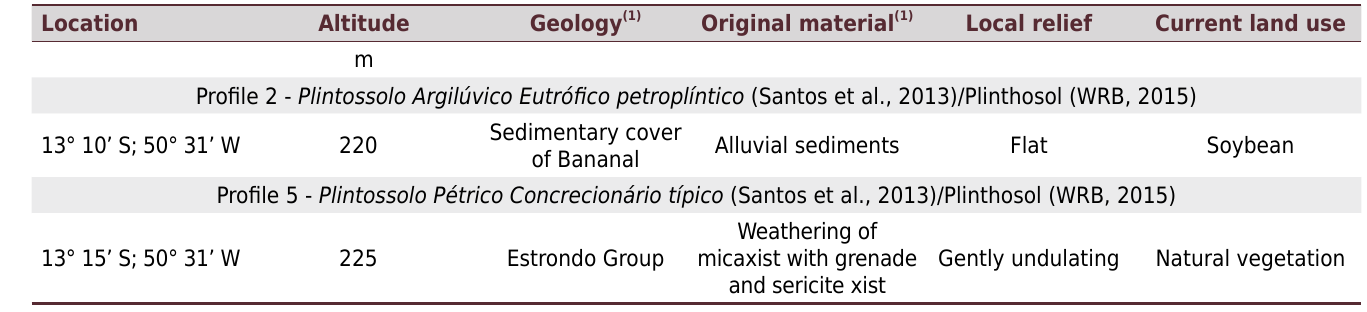
Table 1. Location of the profiles and characterization of the study sites Location Altitude Geology (1) Original material (1) Local relief Current land use